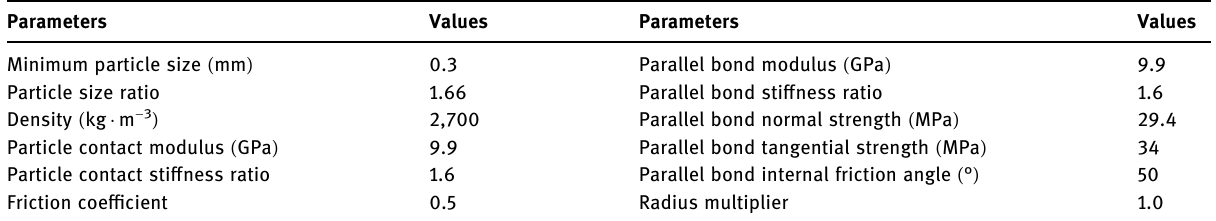
Table 1: Micro - mechanical parameters of numerical rock sample